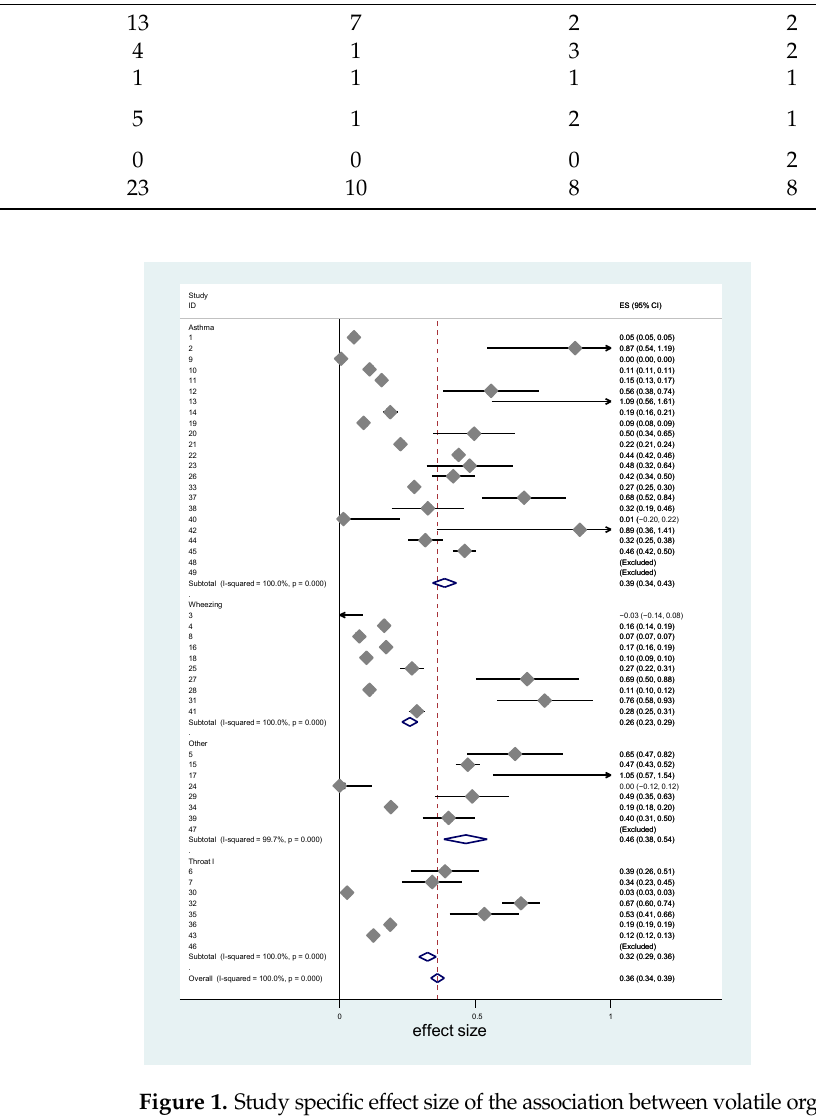
Figure 1. Study specific effect size of the association between volatile organic compound (VOC) exposure and four different health outcomes: development of asthma, wheezing, throat irritation and others (which included respiratory symptoms and diseases). The red dash line represents the average effect